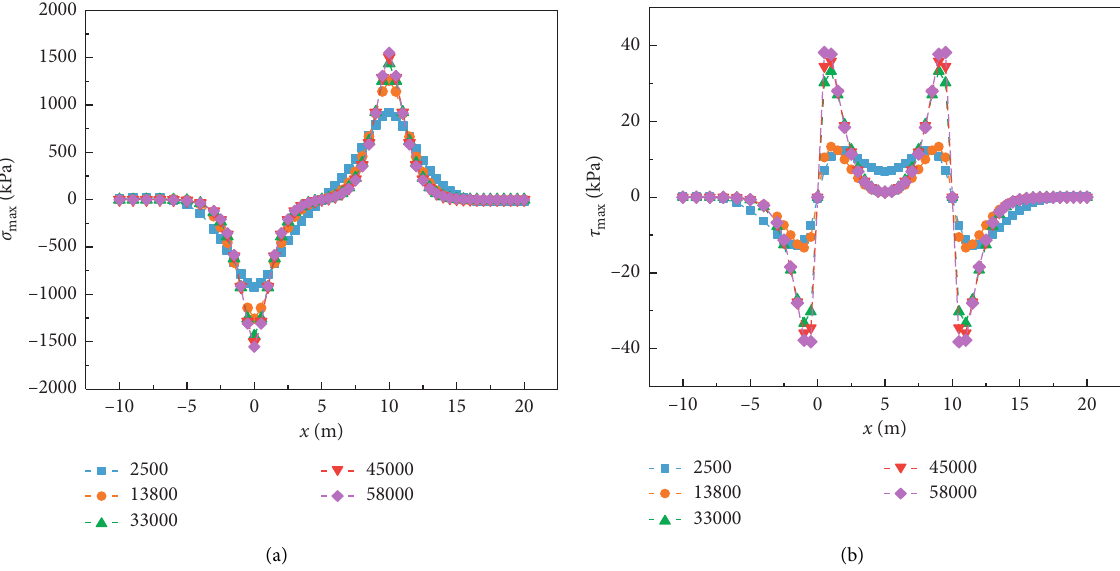
Figure 4: Distribution law of maximum normal stress (a) and maximum shear stress (b) of bottom lining under different foundation